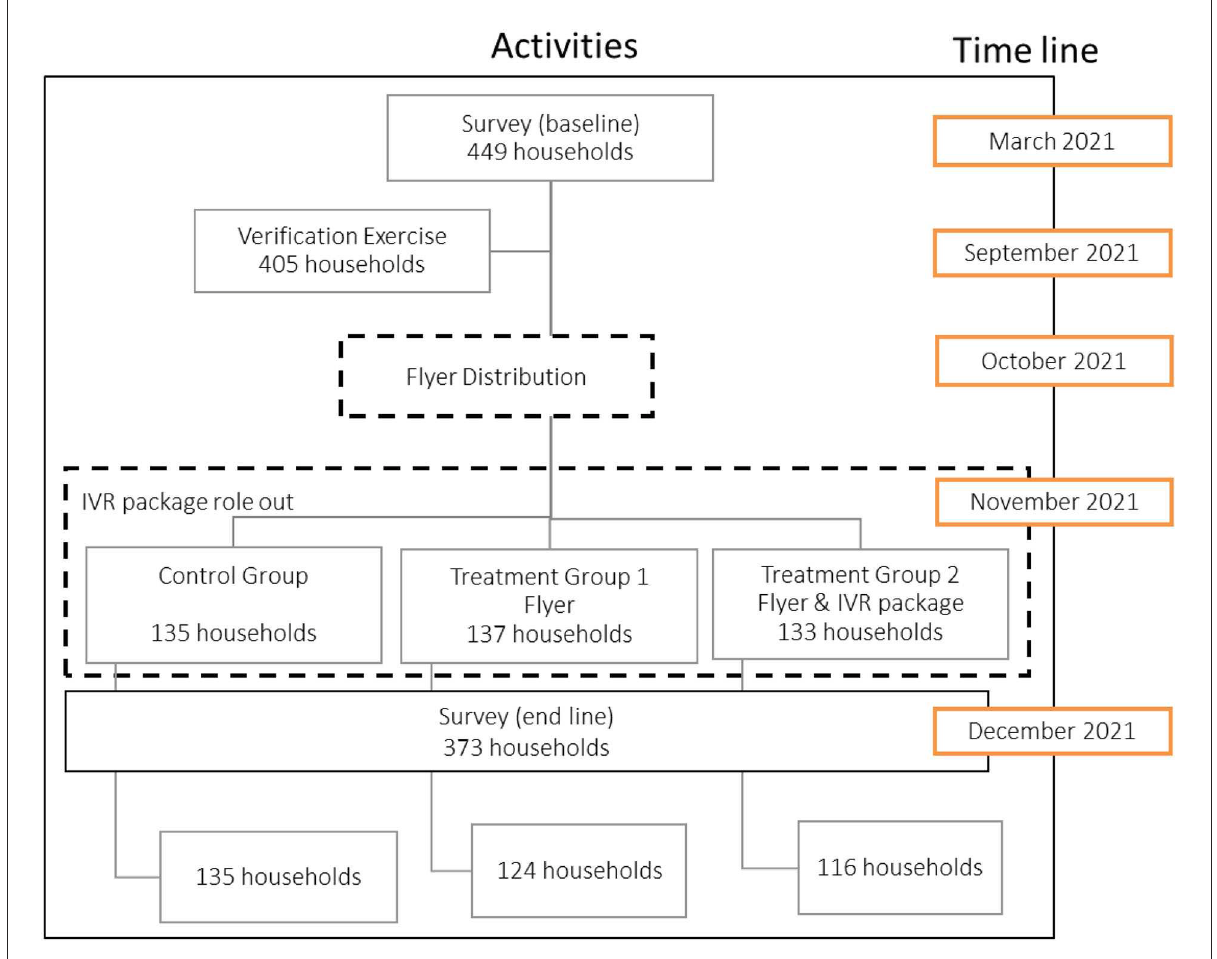
FIGURE1 Study design and timeline.